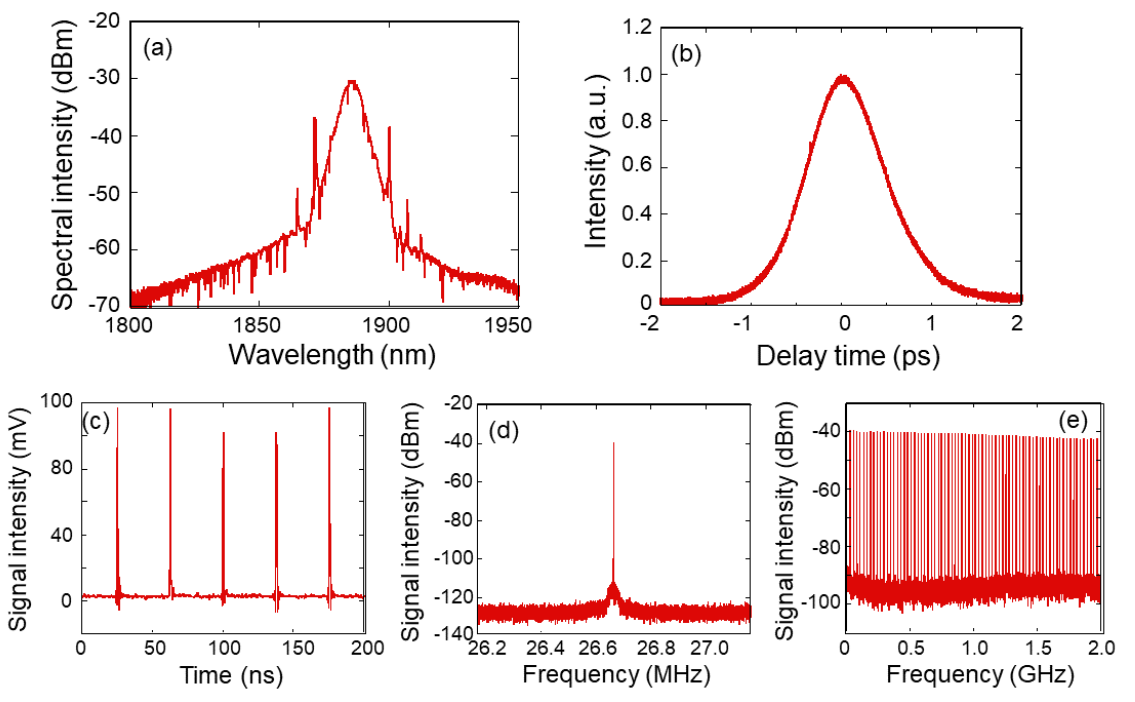
Figure 5. Characteristics of output pulses when D = − 0.144 ps 2 and spectral filter was not used, ( a ) optical spectra, ( b ) autocorrelation trace, ( c ) pulse train, ( d , e ) RF spectra of ( d ) fundamental frequency and ( e ) wide range.